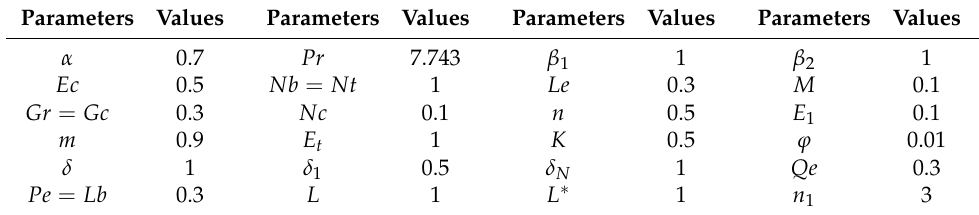
Table 4. Default Values of emerging